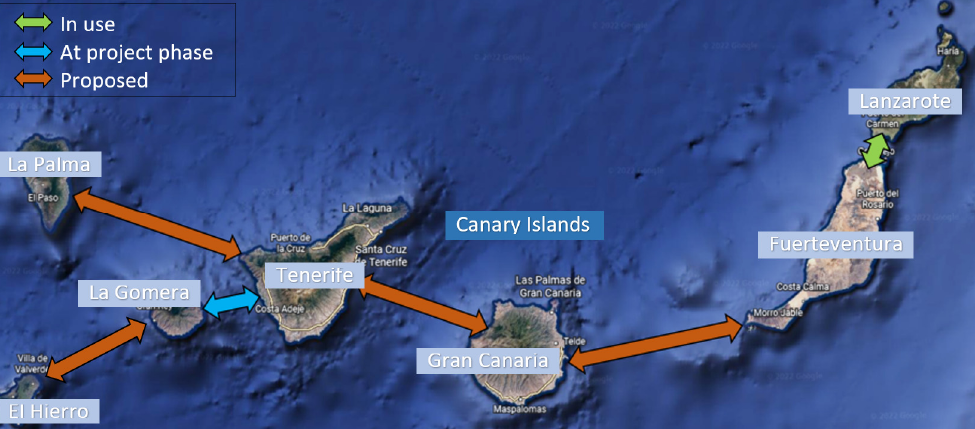
Figure 6. Proposed grid interconnection between the different islands of the Canary Archipelago.